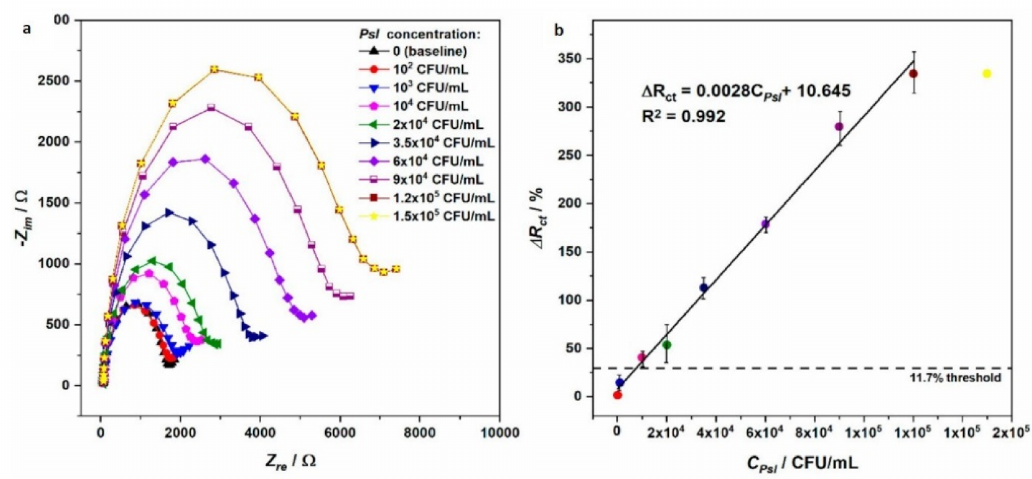
Figure 3. ( a ) Impedance changes obtained with Au/4-ATP/GA/anti-Psl/BSA electrodes, in the case of different concentra- tions of Psl; ( b ) linear relation between charge transfer resistance changes ( ∆ Rct) and bacteria concentrations (on the right) (reproduced from [49], licensed under the Creative Commons